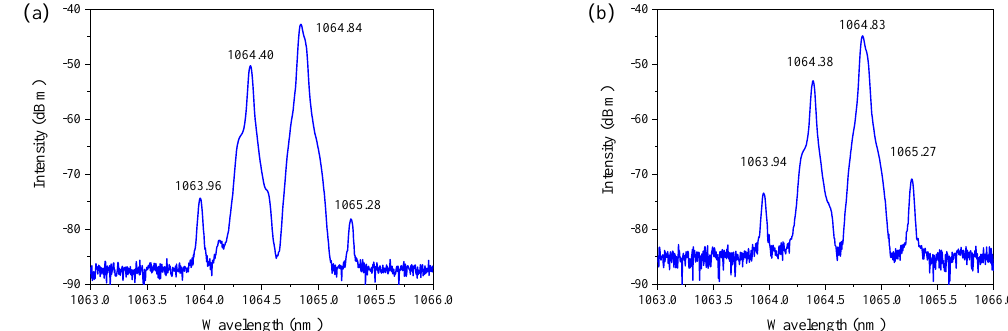
Figure 2. The fine spectrum of ( a ) the seed and ( b ) the fiber amplifier at the maximum output power with an OSA resolution of 0.02 nm.